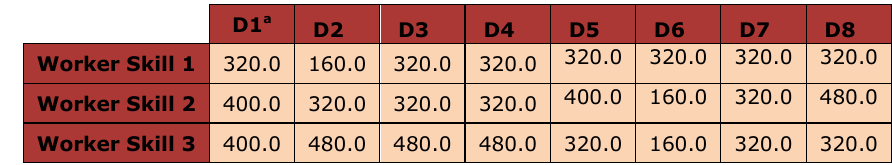
Table 2. Demand of Worker Skills in Each Week (worker-hours)